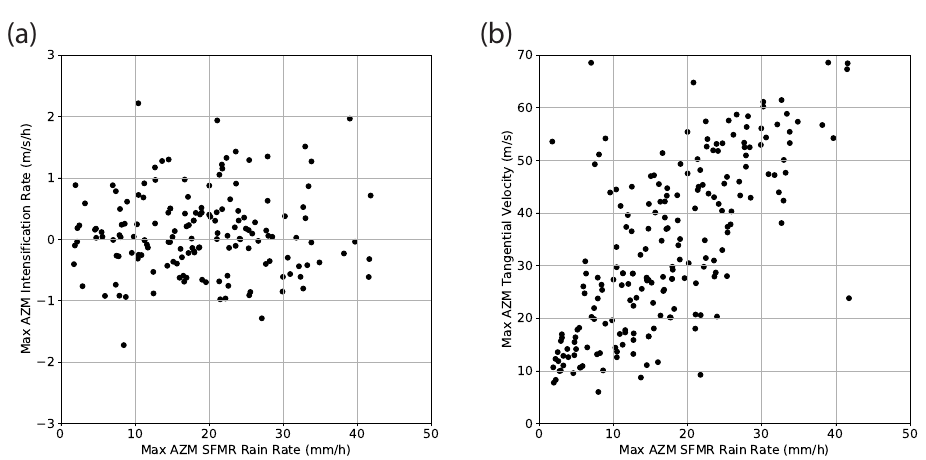
Figure 12. Correlations of azimuthal mean quantities from the FLIGHT+ Dataset azimuthal means. ( a ) Scatterplot of the subsequent change in the maximum azimuthal mean tangential velocity versus the maximum azimuthal mean SFMR rain rate, and ( b ) scatterplot of the maximum azimuthal mean tangential velocity versus the maximum azimuthal mean SFMR rain